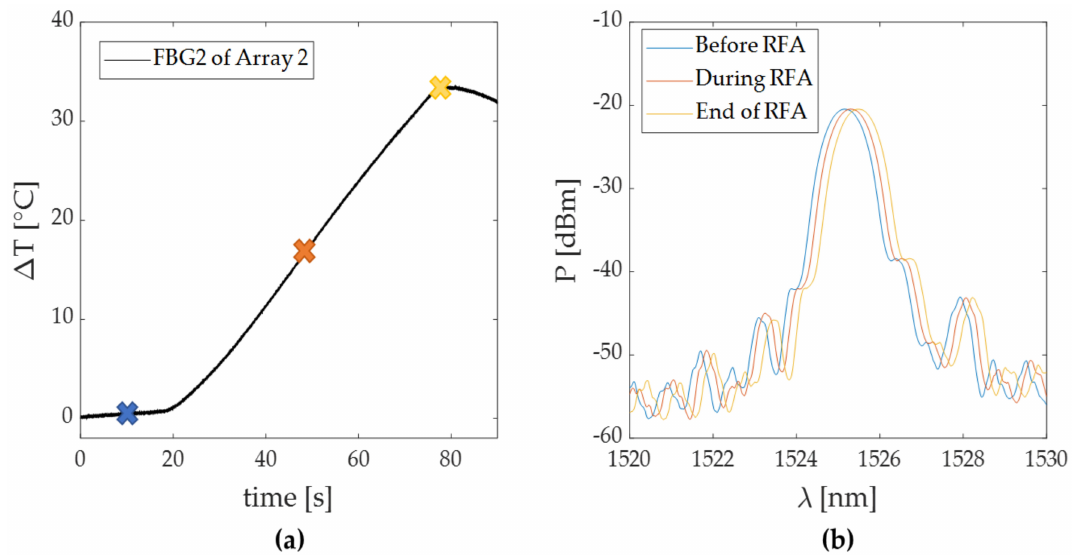
Figure 8. Focus on the temperature variation recorded during Trial 2 by FBG 2 of Array 2: ( a ) temperature trend zoomed on the pre-treatment and RFA phases; ( b ) optical spectra relative to the FBG 2 recorded during the three di ff erent steps of the procedure marked as ( a ): before (blue line), during (red line) and at the end of the RF treatment (yellow line).